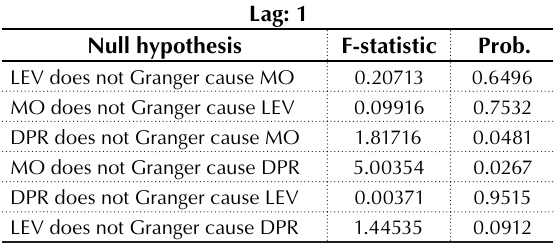
Table 3. Granger causality test results